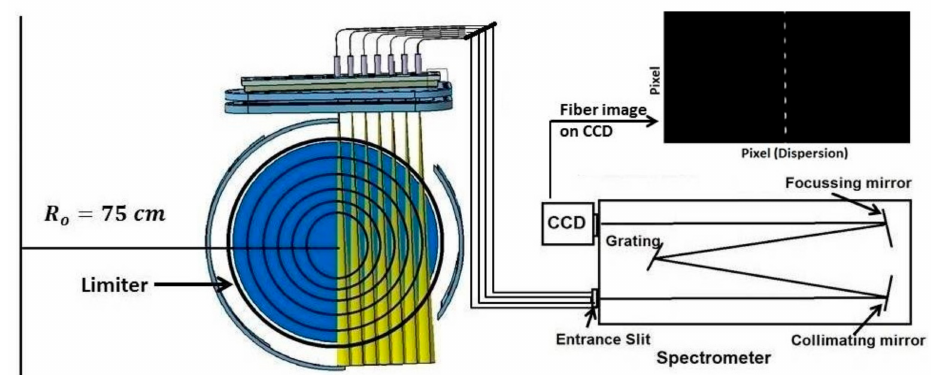
Figure 1. The lines of sight (LoS) for poloidal rotation measurements on Aditya-U tokamak with an image of fibers on the charge coupled device (CCD)